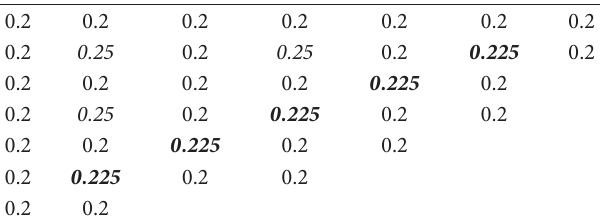
Table 3: Orifice